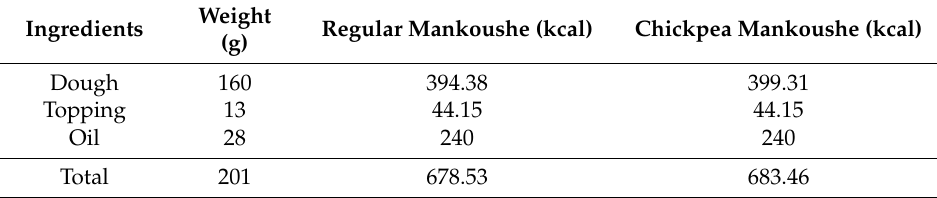
Table 1. Composition and energy content * of test breakfasts “ Mankoushe